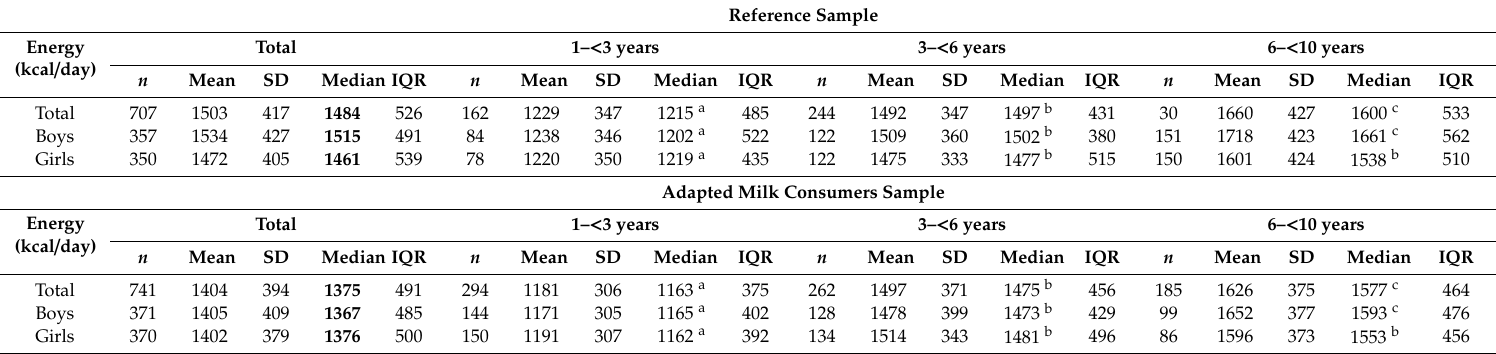
Table 3. Reported energy intake for the Nutritional Study in Spanish Pediatric Population (EsNuPI) according to age group and sex ( n = 1448).